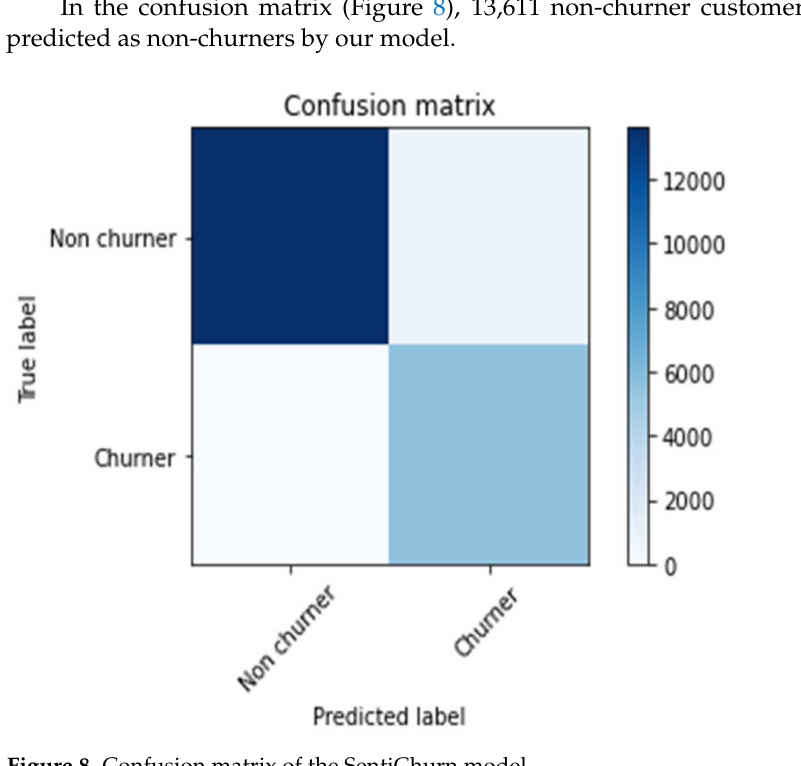
Figure 8. Confusion matrix of the SentiChurn